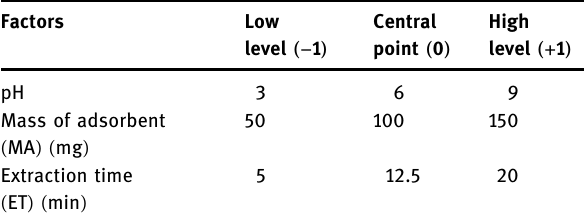
Table 2: Factors and levels used in the 2 3 - factorial design for extraction and preconcentration